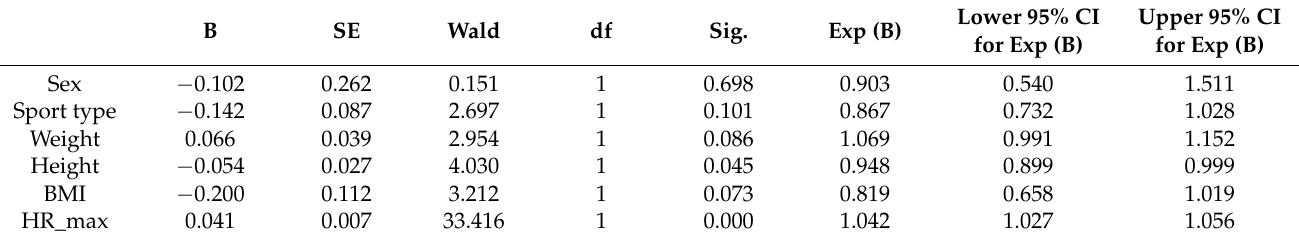
Table 3. Multivariate logistic regression analysis of factors associated with a positive family history of sudden cardiac death and cardiovascular disease (SCD + SVD) in athletes. The table shows the results of multivariate logistic regression analysis to identify factors associated with a positive family history of SCD + SVD in a cohort of 13,876 athletes. The analysis includes variables such as sex, sport type, weight, height, body mass index (BMI), and maximum heart rate (HR_max). The table presents the regression coefficient (B), standard error (SE), Wald statistic, degrees of freedom (df), significance level (Sig.), and odds ratio (Exp (B)) with corresponding 95% confidence intervals (CIs).